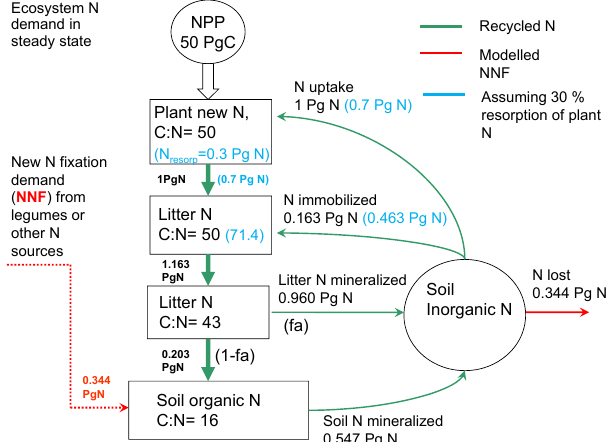
Figure 1. Schematic of stocks flows of N in steady state, as mod- elled by